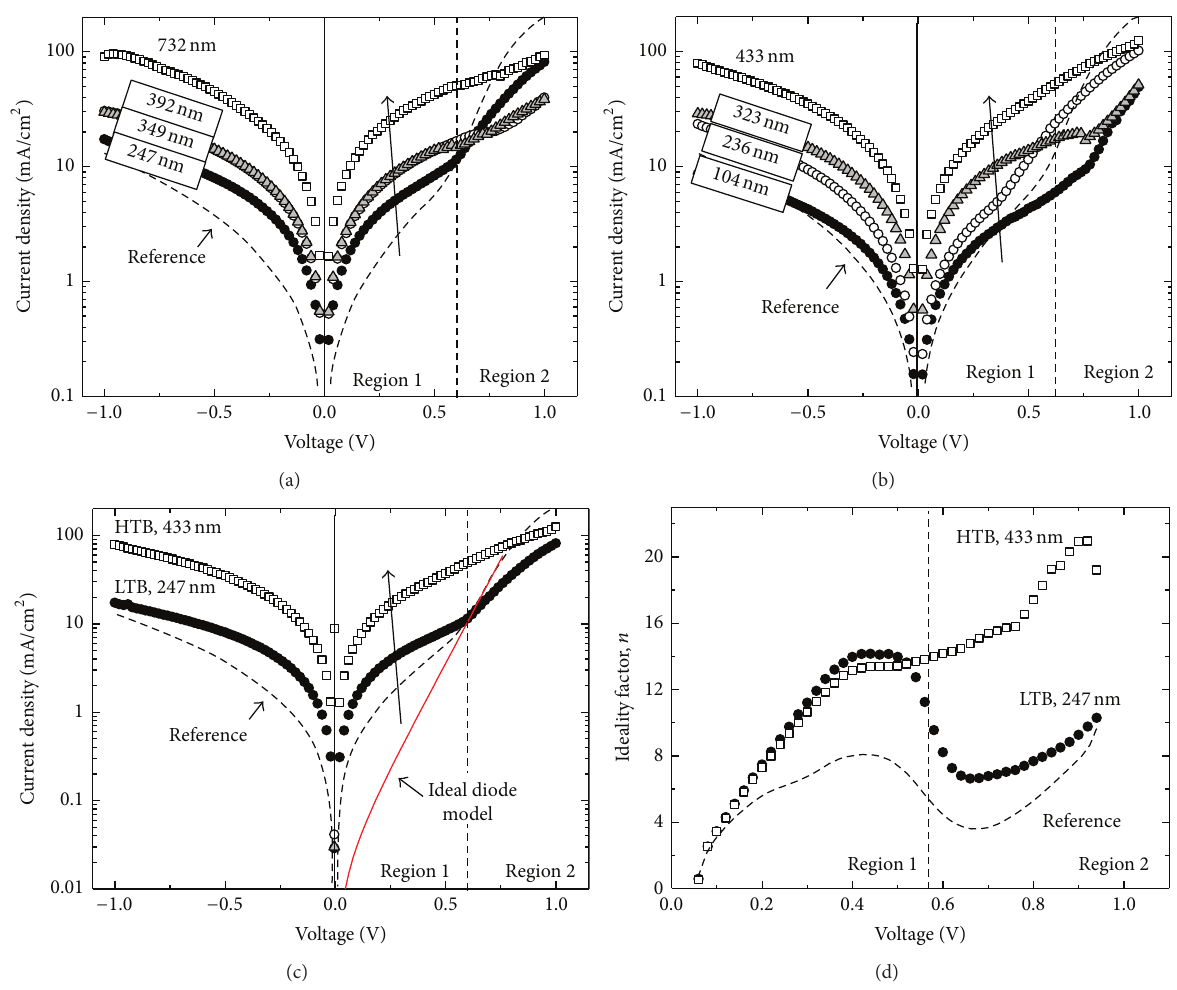
Figure 6: Dark 𝐽 - 𝑉 curves of CIGS samples with the ZnO:Al layer deposited under (a) low thermal budget and (b) high thermal budget conditions for different ZnO:Al thicknesses in each case (thickness values are indicated on each curve). The response from the reference cell is also included. (c) A comparison of the dark 𝐽 - 𝑉 response for low thermal budget ( 𝑑 and reference samples. Bold arrows in (a)–(c) indicate the increased leakage current with increased thermal budget. (d) Ideality factor as a function of voltage, calculated for the curves shown in (c) using the ideal diode